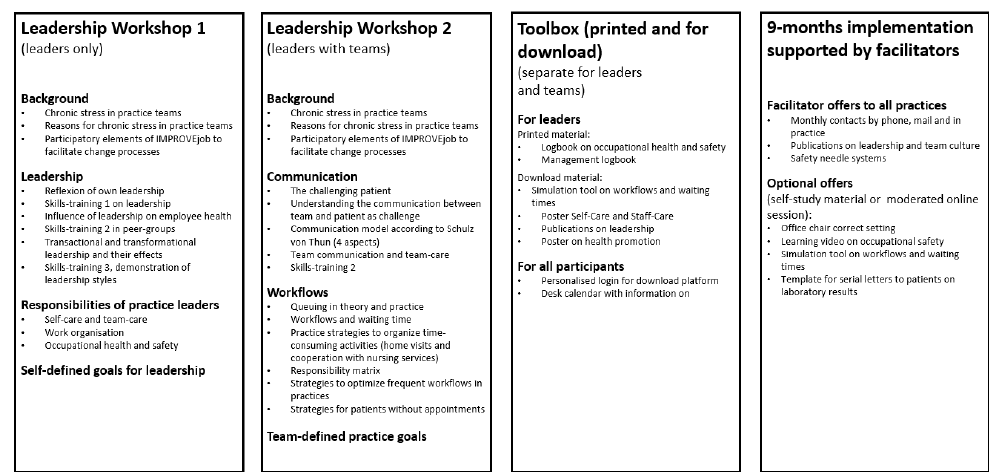
Figure 3. Elements of the IMPROVE job intervention.